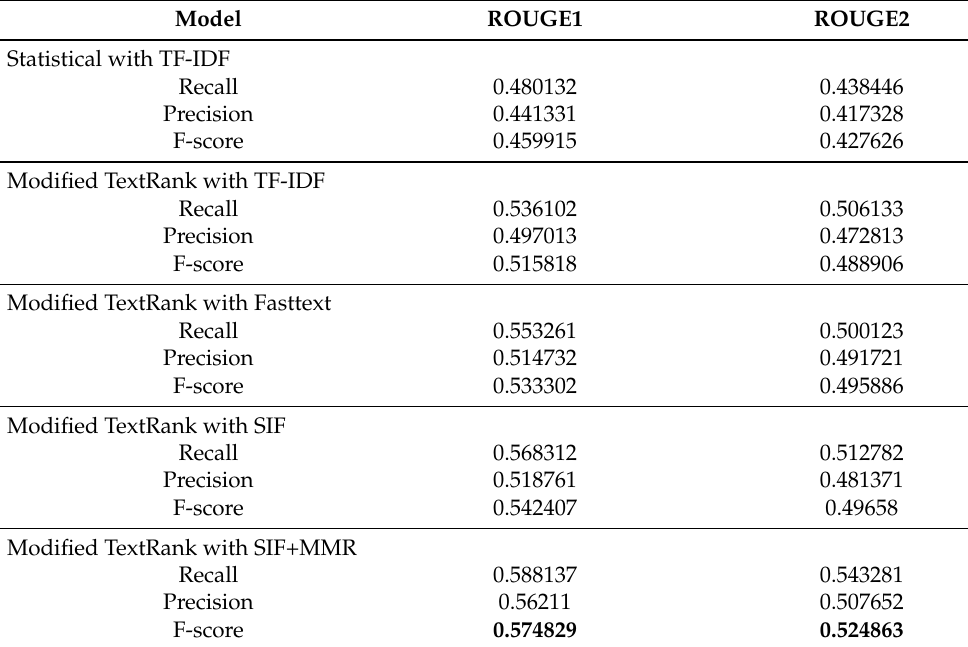
Table 6. Comparison of the Research